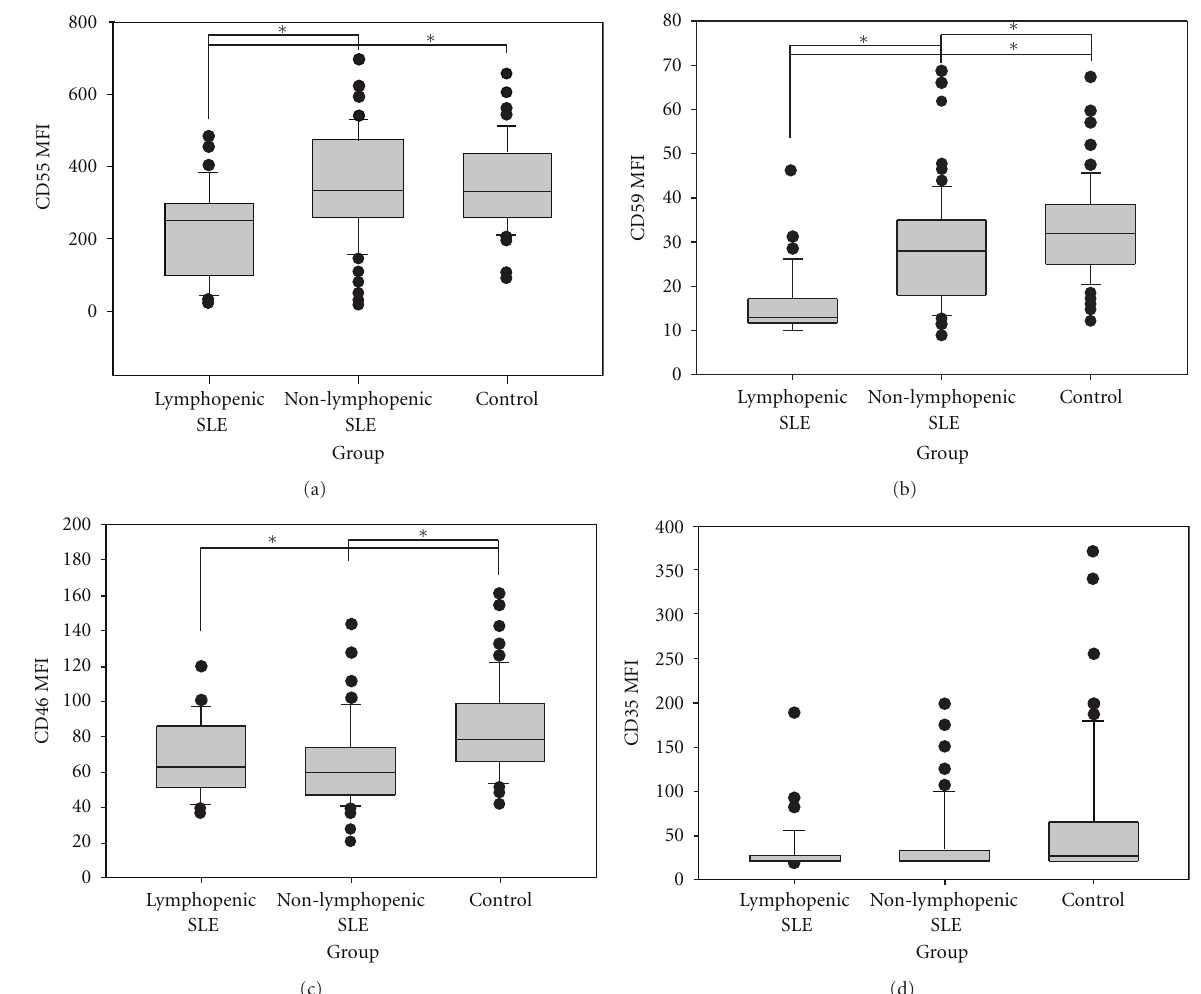
Figure 2: Creg surface expression of lymphocytes cell. The figure displays mean fluorescence intensity (MFI) of CD55, CD59, CD46, and CD35 on gated neutrophil from SLE patients with lymphopenia, without lymphopenia, and controls. Median and interquartile range from all subjects studied in each group were shown. ∗ Significant statistical di ff erence ( P < 0 .